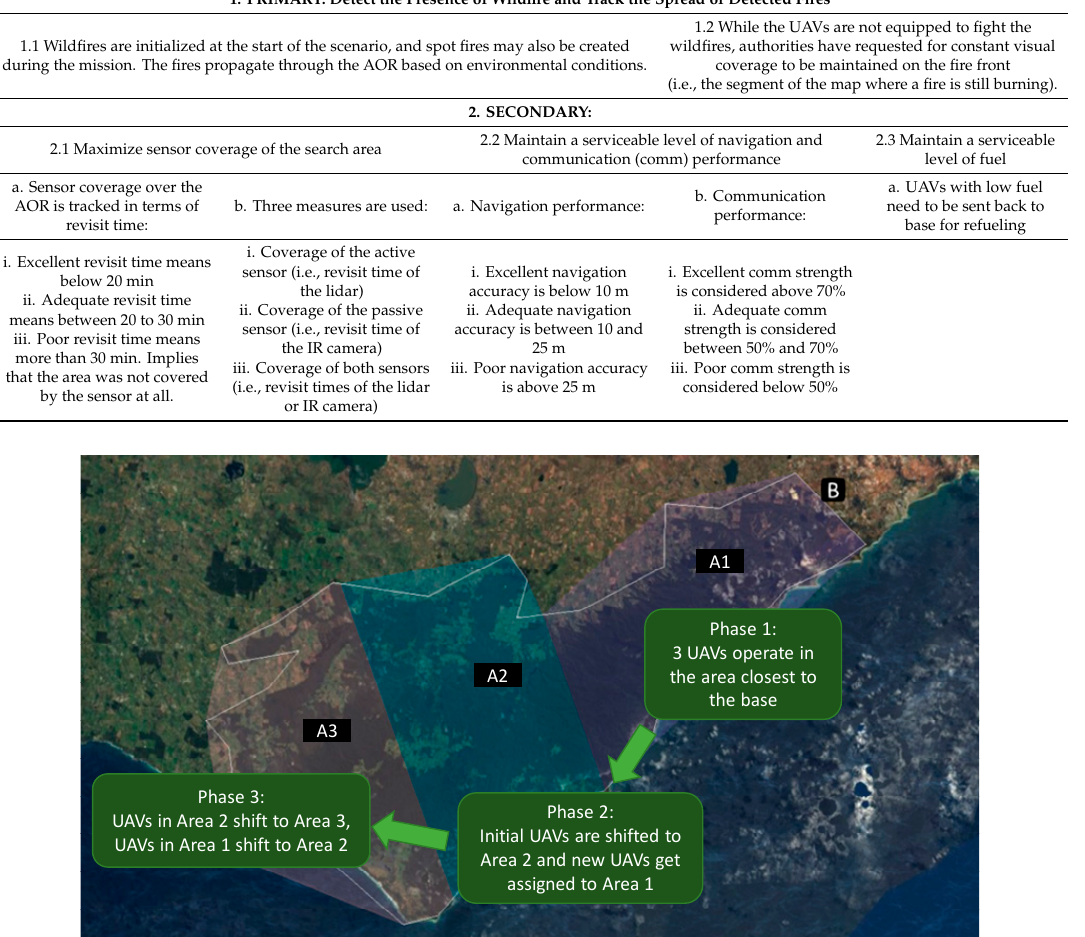
Table 1. Primary and secondary mission objectives.